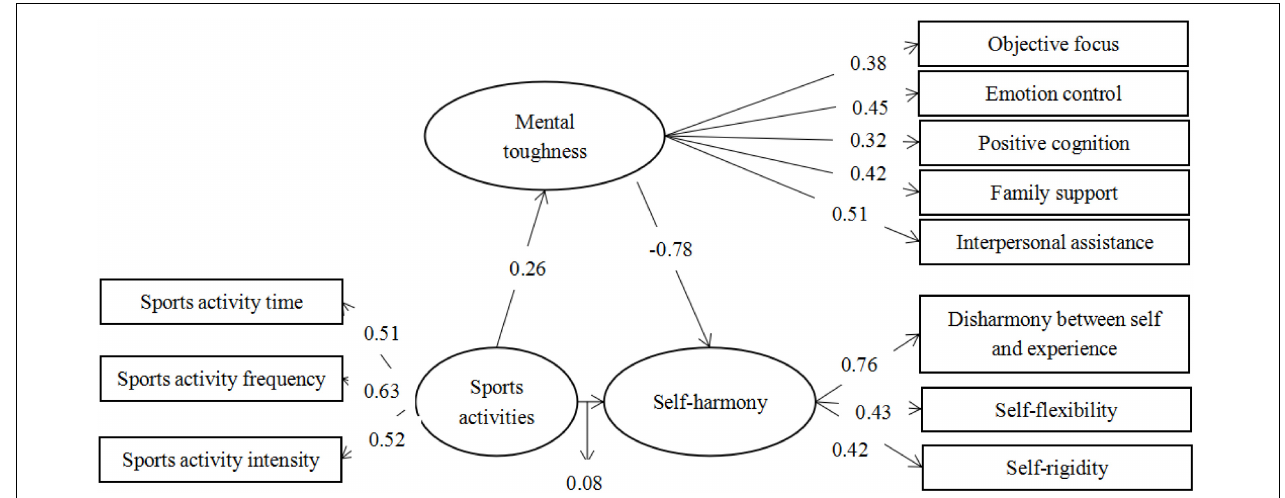
FIGURE 1 | Path analysis of intermediate